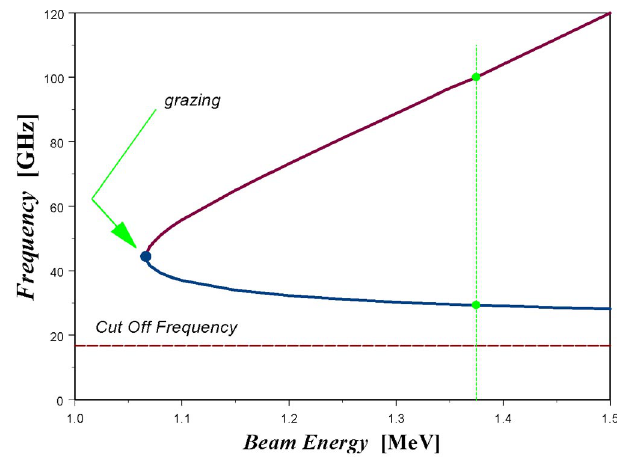
FIG. 5. (Color) Dispersive waveguide solutions for the radiation frequencies as a function of the acceleration beam